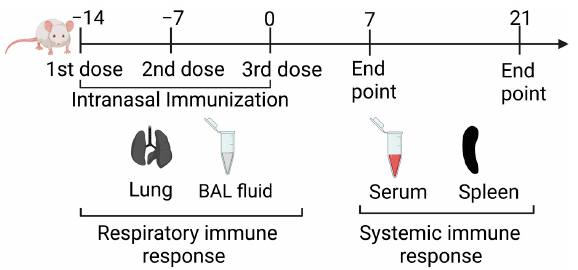
Figure 4. Schematic of the study timeline for vaccine dosing to investigate the time course of immune responses to nasal-nano vaccine in BALB/C mice. Two groups of female BALB/C mice ( n = 3) were immunized 3 times across their nasal nares with the respective nanoparticles 7 days apart. Mice were then humanely euthanized days 7 and 21 post immunization for first and second group, respectively. Lungs, spleen, BALF, and serum were harvested upon sacrifice to investigate immune responses to vaccine.